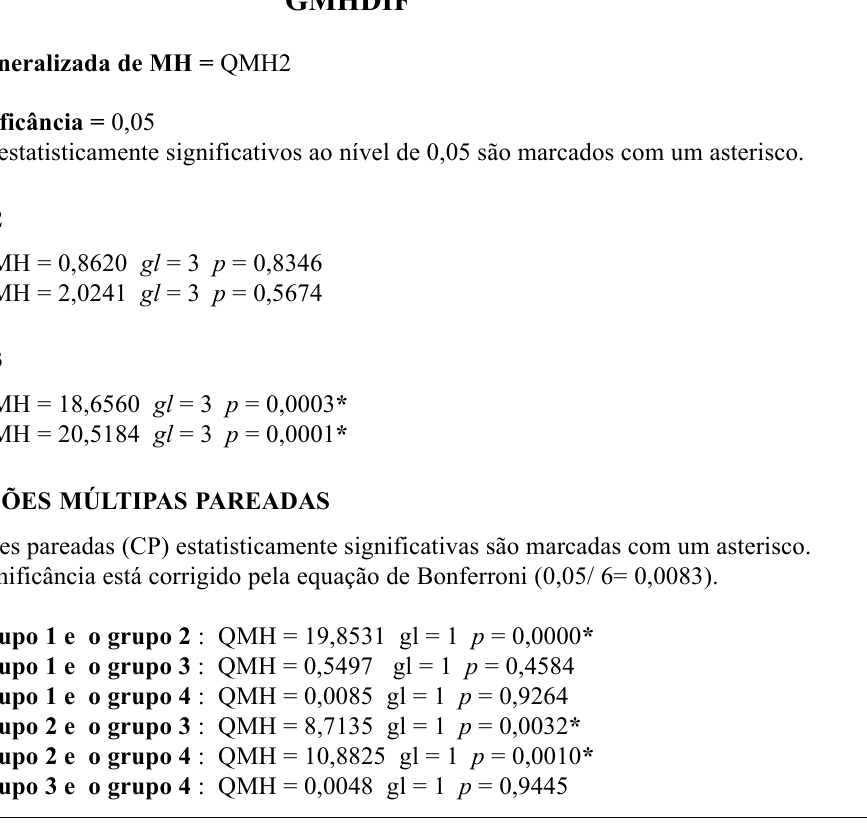
Figura 2. Saida com os resultados de uma análise do DIF em duas etapas na que se comparavam quatro grupos